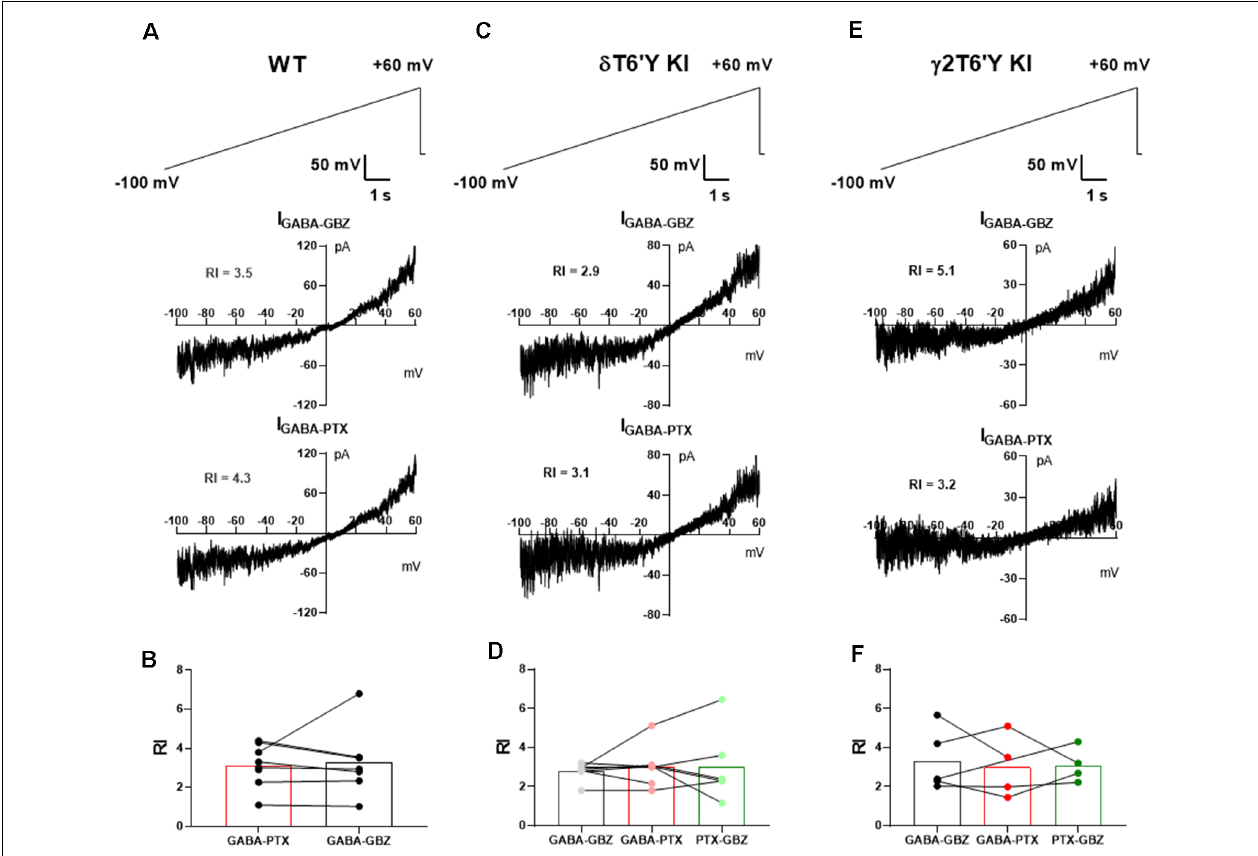
FIGURE 2 | Rectification does not differ among GABA A R isoforms in slice recording. (A) In a representative WT DGC, GABA A R-mediated tonic current shows outward rectification. (B) Summary of GABA A R rectification index (RI). PTX and GBZ show similar blockage of GABA A R-mediated tonic current in WT DGCs ( n = 7, paired- t test, 3.1 ± 0.4 vs. 3.3 ± 0.7, p = 0.8275). (C,D) Tonic current mediated by δ -containing GABA A Rs shows outward rectification. Note that RI of total